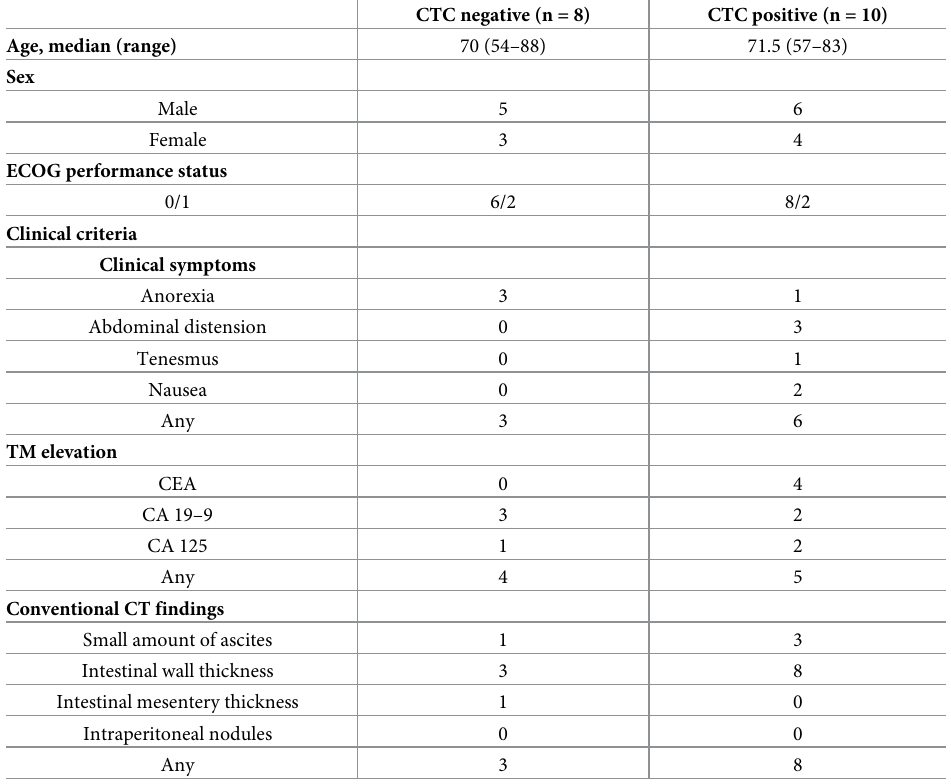
Table 1. Patient characteristics.